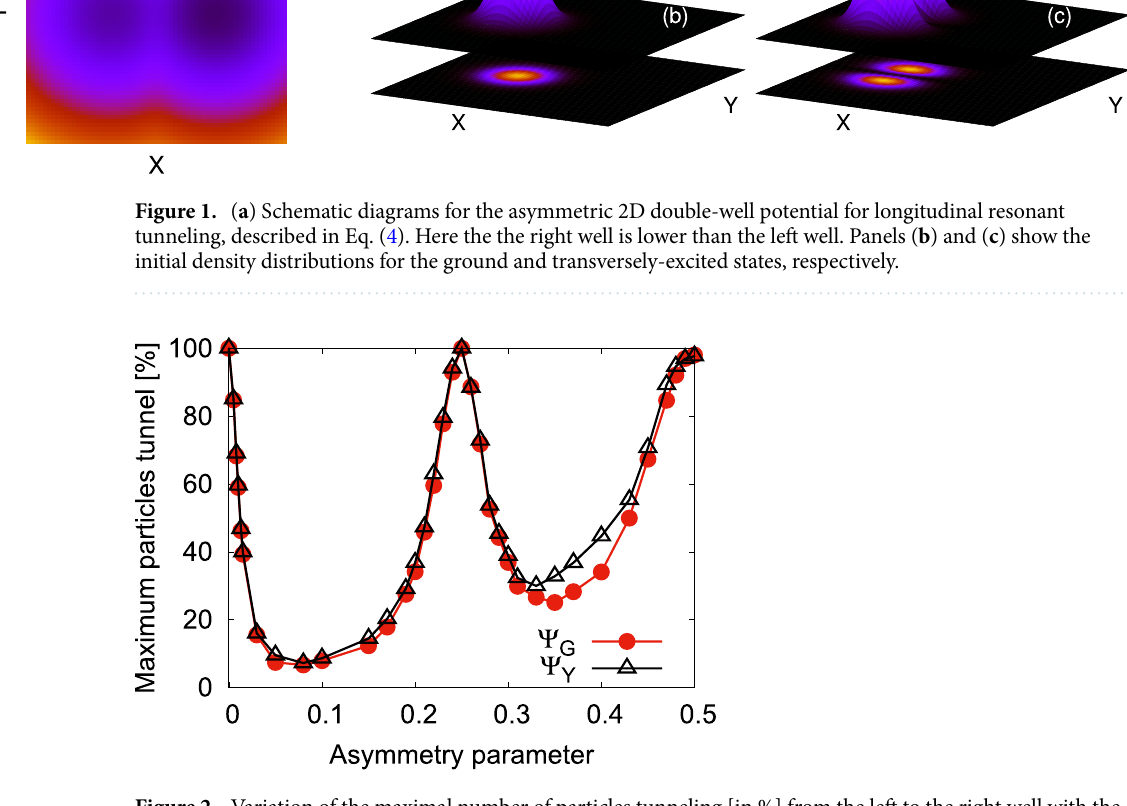
Figure 2. Variation of the maximal number of particles tunneling [in %] from the left to the right well with the asymmetry parameter c for the states (cid:31) G and (cid:31) Y at the mean-field level. The data is generated from the time- dependent solution of the Gross-Pitaeveskii equation. We show here dimensionless